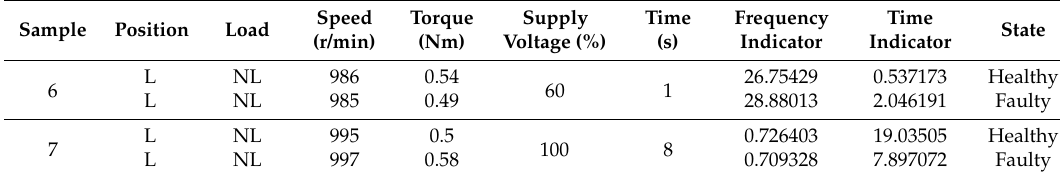
Table 17. Results of the time and frequency indicators for the L